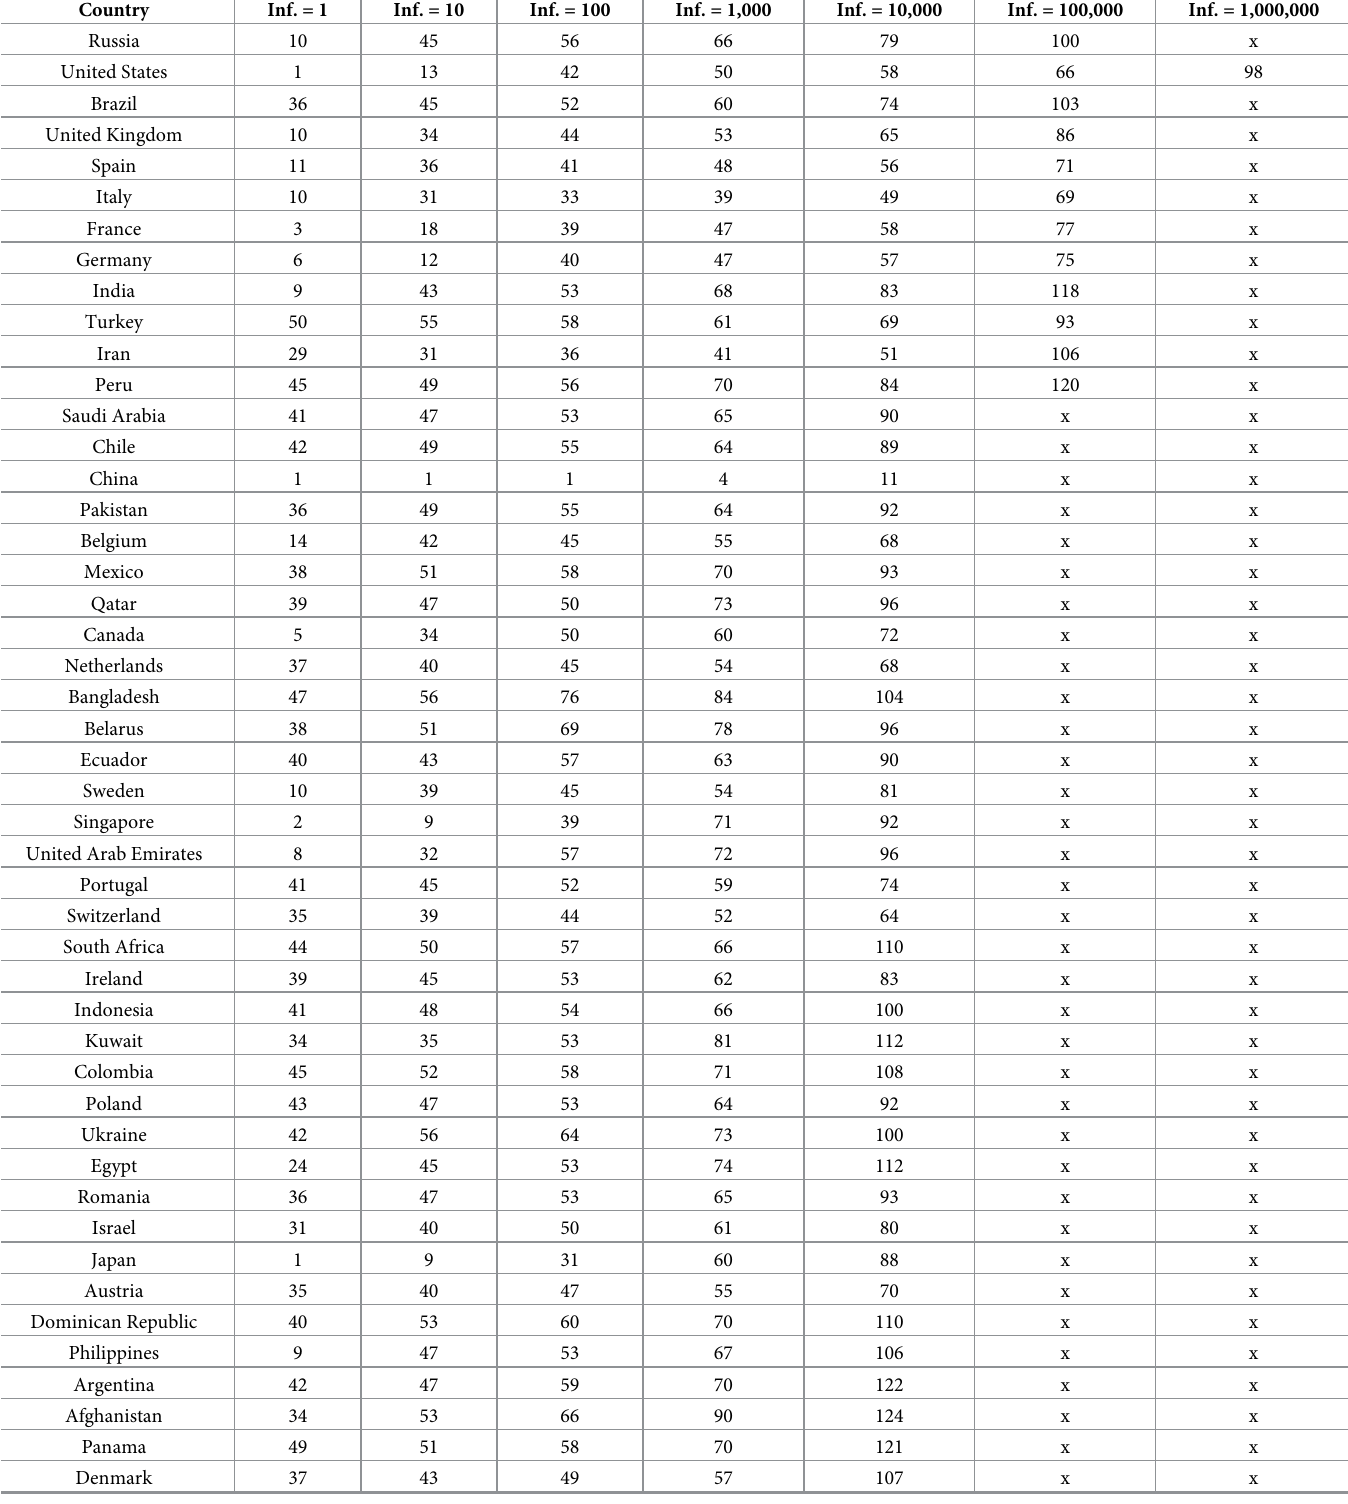
Table 1. Pandemic progression.